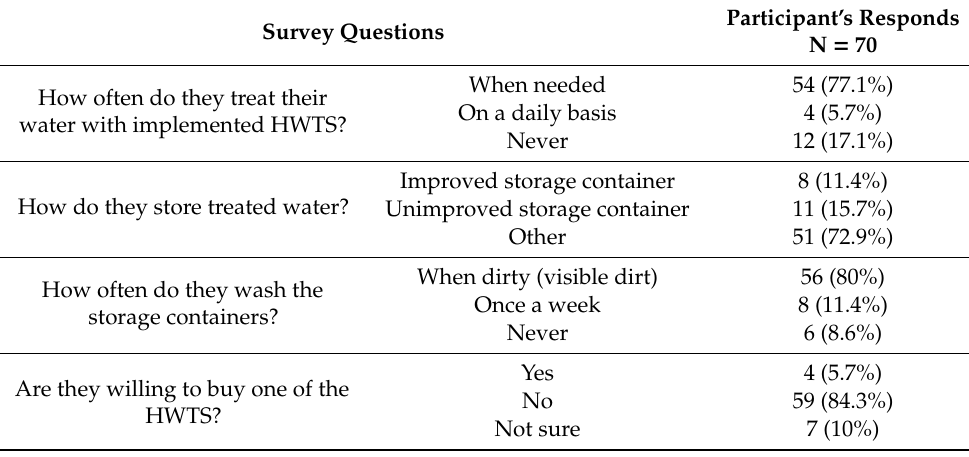
Table 5. Responds obtained during the survey subsequent to the implementation of HWTS in Makwane